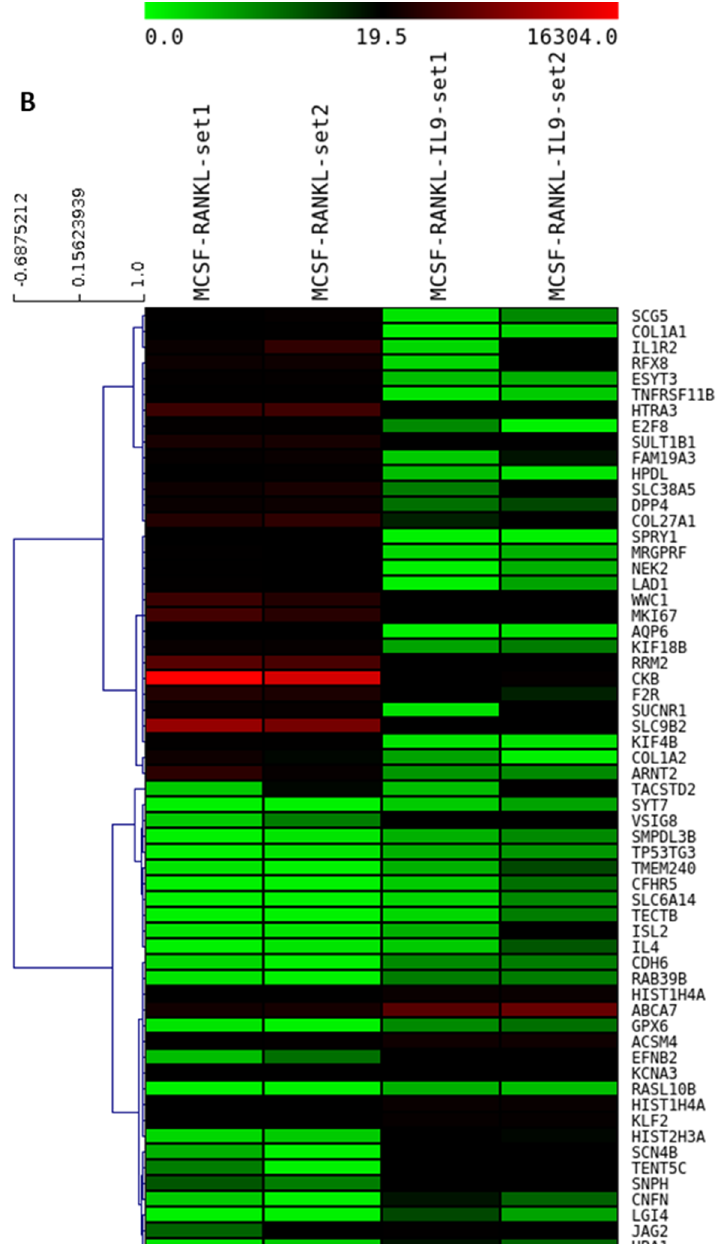
Figure 3. IL-9 mediated differential gene expression profile during osteoclastogenesis in RA. Cells derived from synovial fluid (SF) of patients with RA were treated with macrophage colony-stimulating factor (M-CSF; 25 ng/mL) and soluble receptor activator of nuclear factor κ B ligand (sRANKL; 50 ng/mL) in the presence or absence of rIL-9 (100 ng/mL) for 4 days. After that RNA sequencing was performed with the treated cells as described in Materials and Methods. ( A ) Volcano plot of differentially expressed genes between M-CSF + sRANKL-treated cells and M-CSF + sRANKL + rIL-9-treated cells. ( B ) Heatmap of hierarchical cluster analysis of differentially expressed genes between M-CSF + sRANKL-treated cells and M-CSF + sRANKL + rIL-9-treated cells.